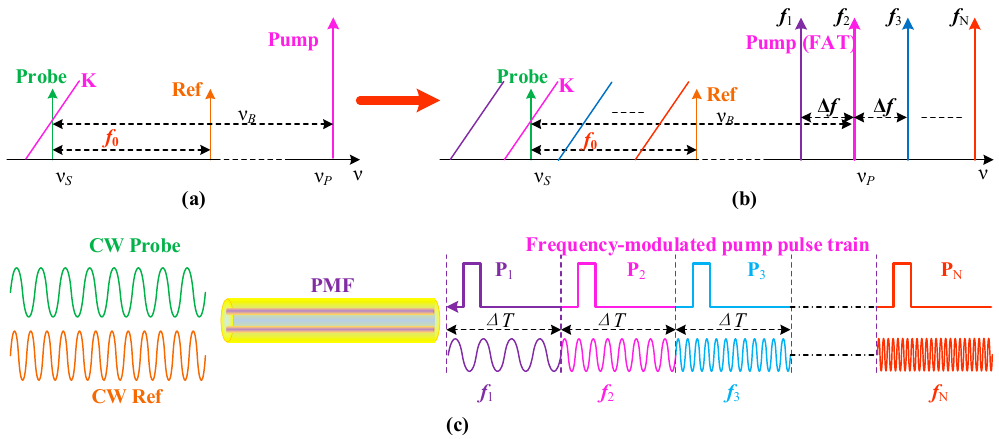
Figure 12. The operation principle of ( a ) the single-slope and ( b ) the multi-slope assisted BOTDA. ( c ) The time relationship between the pump pulse and the probe wave [11].